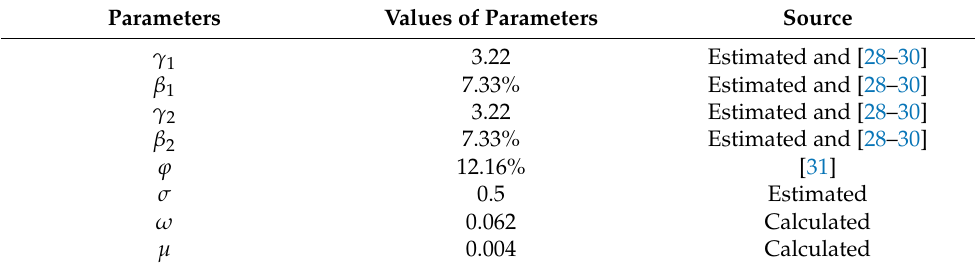
Table 2. Details of